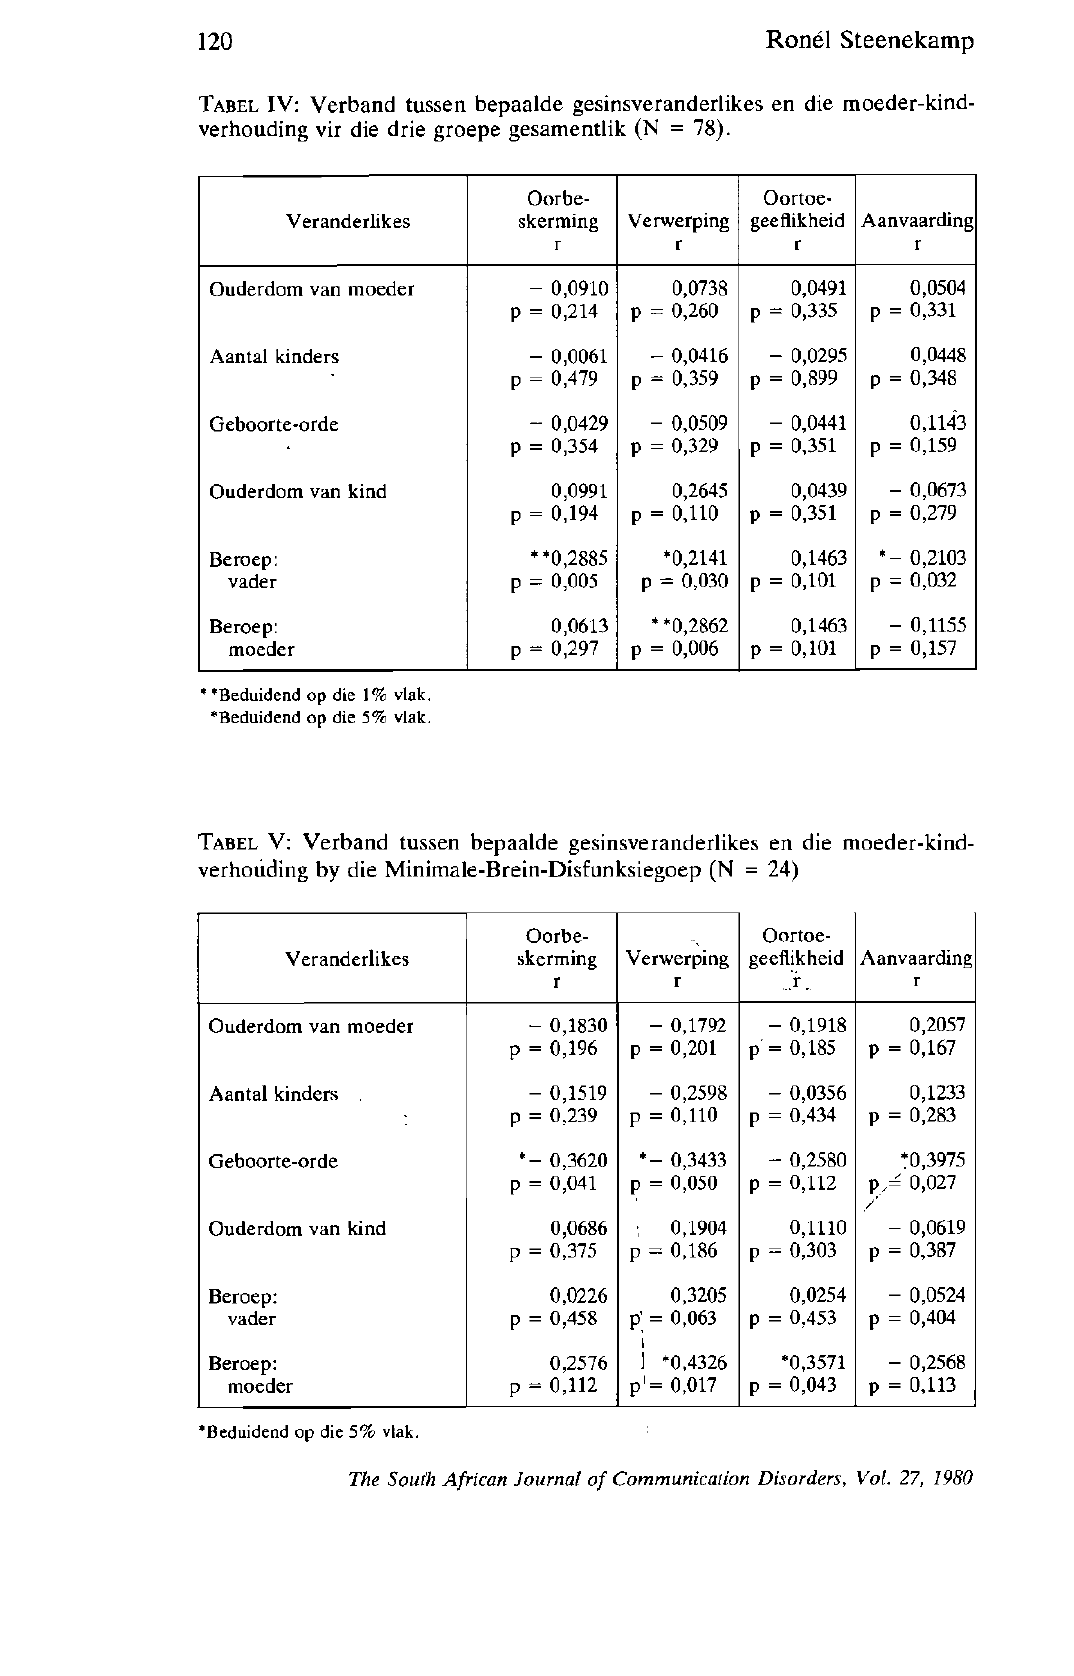
TABEL IV: Verband tussen bepaalde gesinsveranderlikes en die moeder-kind-